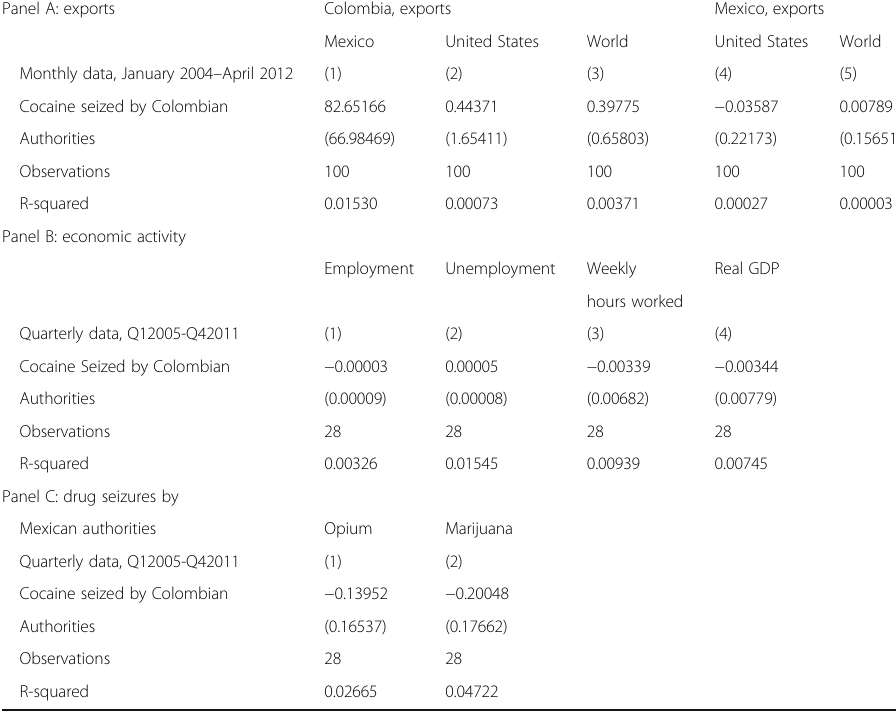
Table 10 Cocaine seizures in Colombia and other economic variables in Mexico or the USA Panel A: exports Colombia,